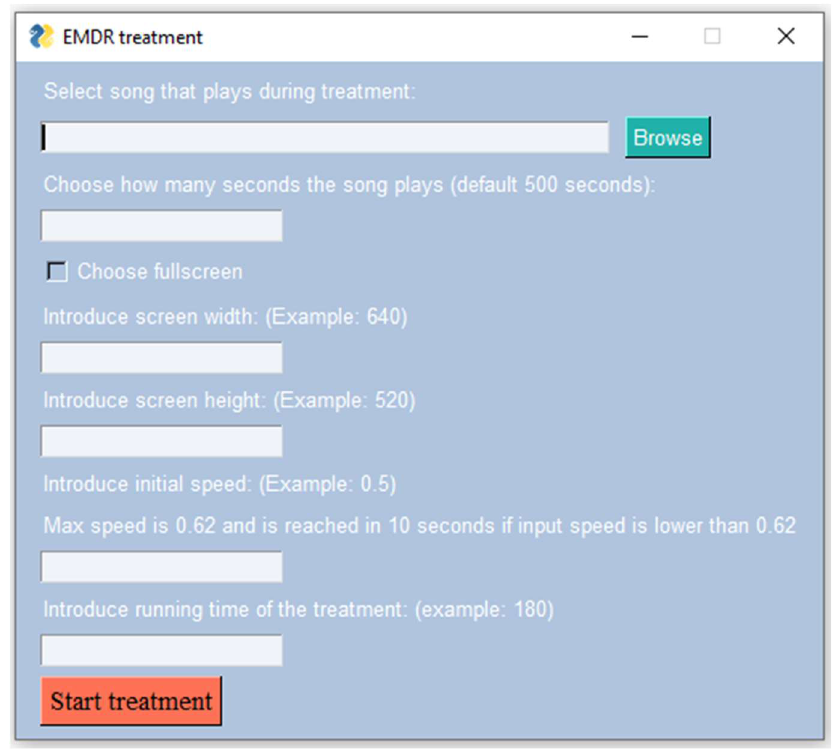
Figure 2. EMDR treatment user interface.